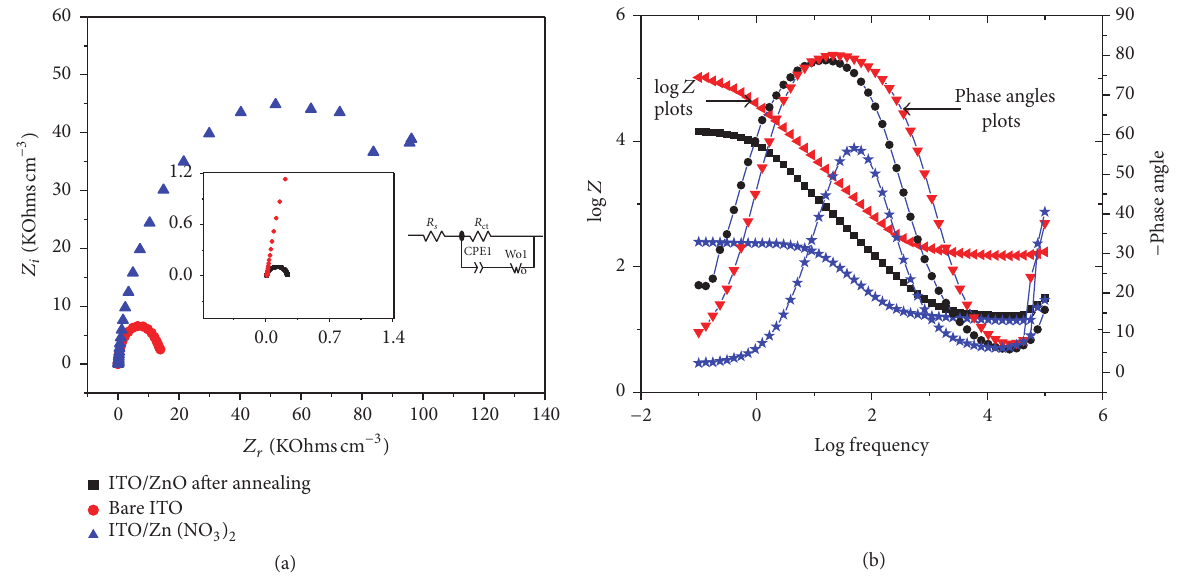
Figure 7: (a) Nyquist plots of bare ITO (blue symbols), ITO/zincate (red symbols), and ITO/ZnO (black symbols) electrodes in 0.1 M PBS (pH = 7.4). (b) The corresponding bode plots of the EIS data in (a).